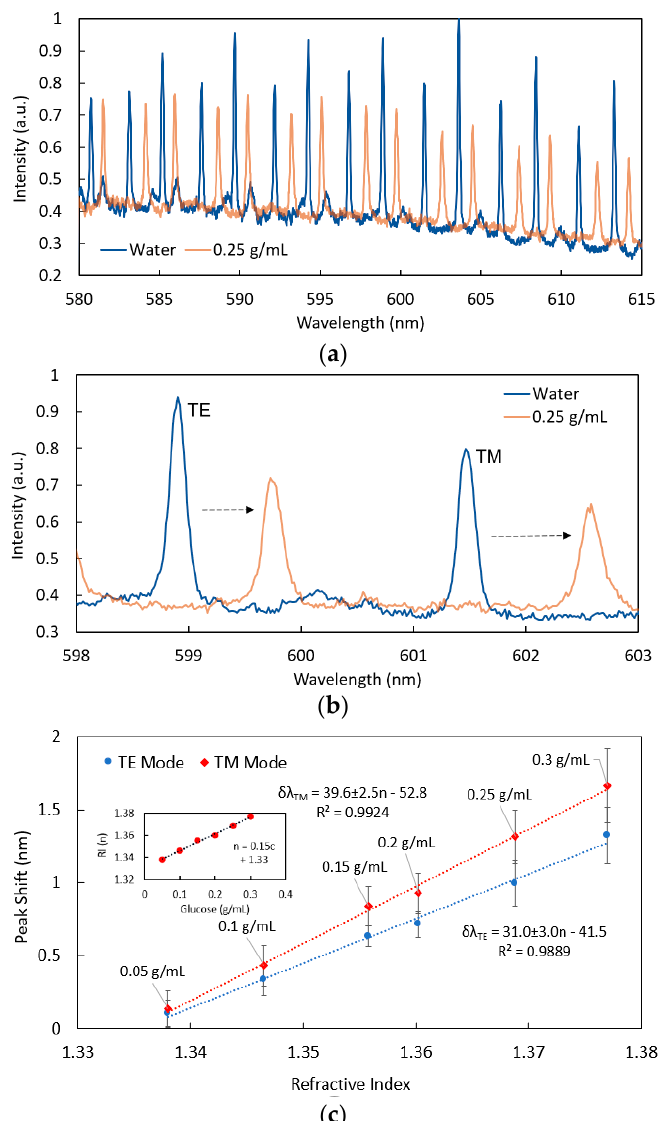
Figure 3. ( a ) Typical normalised WGM-modulated fluorescence spectrum (blue: pure water, orange: 0.25 g/mL glucose in water) of 15 µm microspheres (FSR ~ 4.8 nm) lodged in an open microfluidic chip. ( b ) Wavelength shift of isolated TE and TM resonances from grey-dashed box in ( a ). ( c ) Wavelength shift of TE and TM modes within the microfluidic chip as a function of refractive index. The glucose concentration was converted to refractive index (RI) at 633 nm using [26], with the calibra- tion shown in the inset. In these measurements, a different sphere and chip was used for each meas- urement. The water in the chip for the baseline measurement was also evaporated before the glucose solution was added.